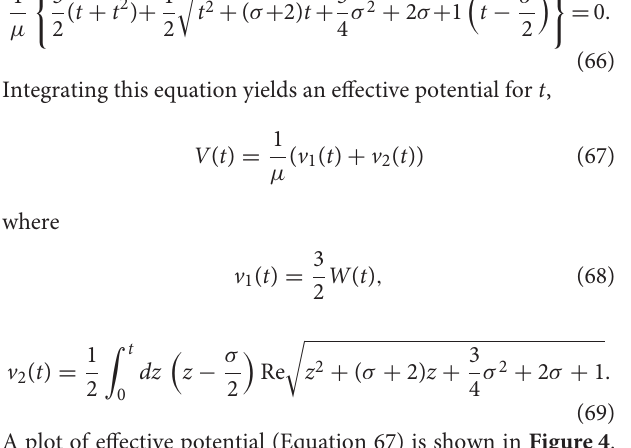
is obtained by an integrating out χ a and a D-brane with the tachyon vacuum where the world-sheet boundary disappears. Therefore, it is natural to think